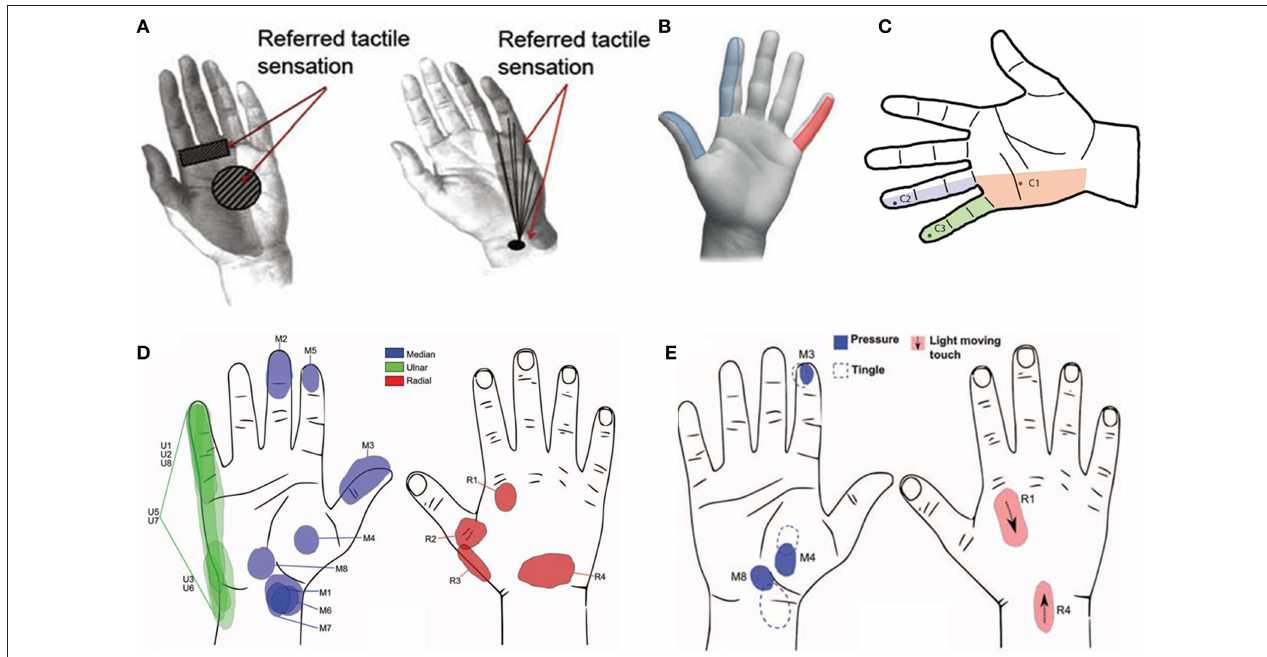
FIGURE 3 | (A) Perceived localization of sensation after—median nerve tf-LIFE4 stimulation on left and after ulnar nerve tf-LIFE4 stimulation on right (Rossini et al., 2010 ); (B) Elicited hand areas in Raspopovic et al. (2014); (C) Tactile perception via neurostimulation (Ortiz-Catalan et al., 2014a). The dark points represent the electrode-specific projected field repeatedly reported (over 11 months) for a single pulse at stimulation threshold; (D) Sensation locations after threshold stimulation at week 3 post-op ( Tan et al., 2014). The letter represents the nerve and the number represents the stimulus channel; (E) Pressure tactile perception on varying of impulse duration (Tan et al.,